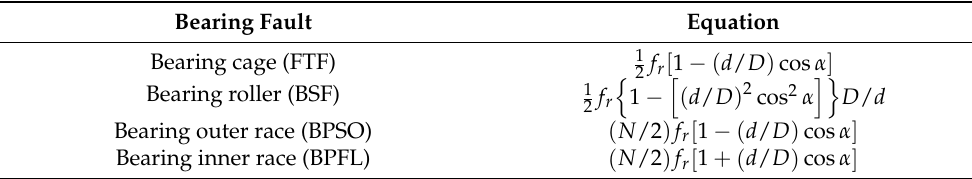
Table 5. Bearing failure characteristic frequency calculation formulas.